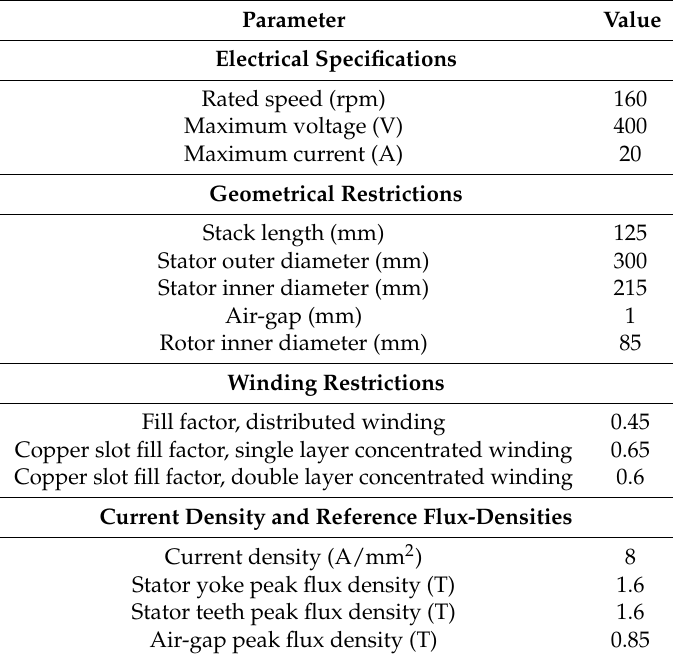
Table 6. Design specifications and